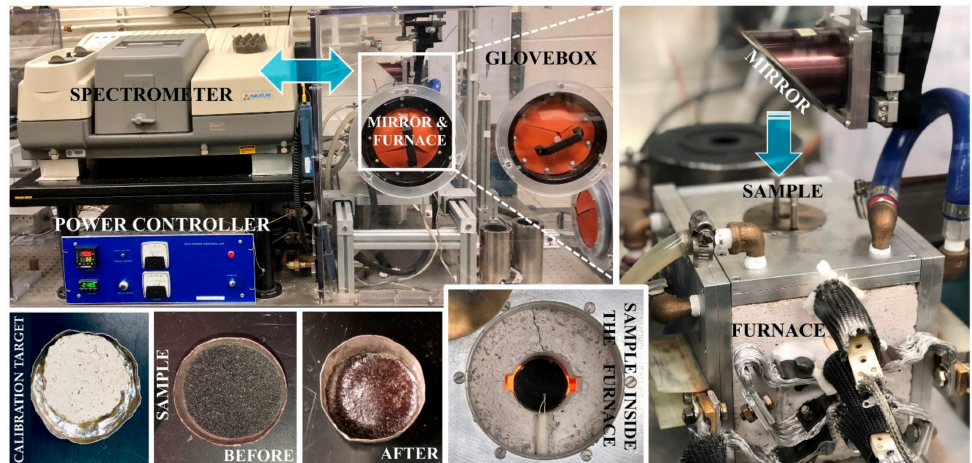
Figure 2. Experimental high-temperature (773–1373 K) setup to measure emissivity at IVIS Laboratory, University of Pittsburgh (USA). Shown is the power controller unit and Nicolet Nexus 870 FTIR spectrometer, adjacent to the experiment chamber ( top right ), which is continuously purged of CO 2 and H 2 O. The experiment chamber contains the furnace and sample measuring apparatus ( right ). The sample before and after measurement is also shown ( bottom left ), and the calibration material (alumina) used as the blackbody